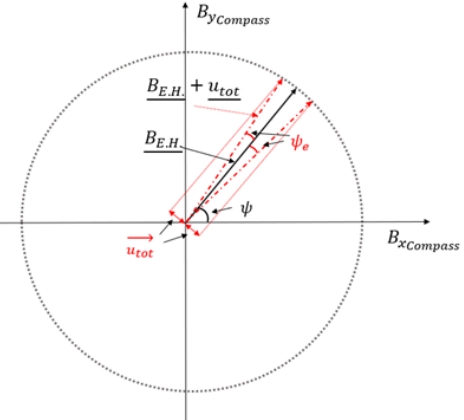
⁡ and 𝐵 𝑦 have values equal to the 𝑐𝑜𝑚𝑝𝑎𝑠𝑠 𝑐𝑜𝑚𝑝𝑎𝑠𝑠